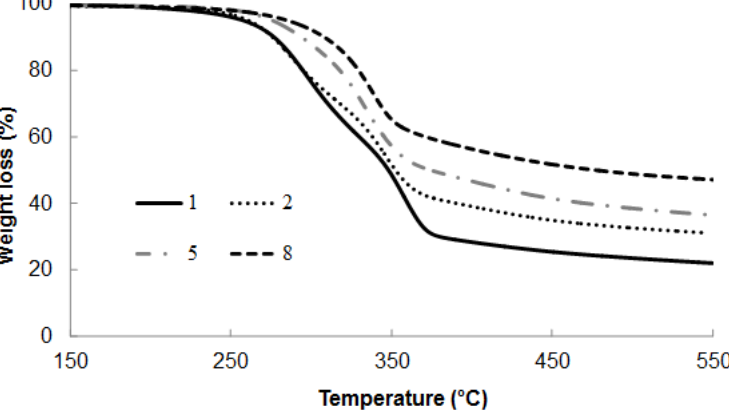
Figure 1. TG analysis for untreated OPMF (1) and SHS-treated OPMF; at 190 °C (2), 210 °C (5) and 230 °C (8), for 1 h of